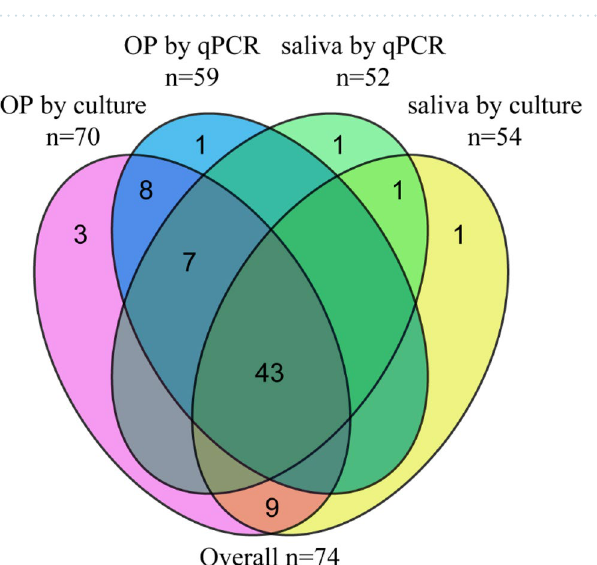
Figure 2. qPCR based detection of Neisseria meningitidis versus isolation of live meningococci from oropharyngeal and saliva samples. A scatter plot of the metA and ctrA qPCR cycle threshold (C T ) values from ( A ) oropharyngeal and ( B ) saliva samples. Each symbol represents an individual sample. Samples with a C T > 25 for both metA and ctrA are considered as positive for meningococcal carriage when tested with molecular methods. In both oropharyngeal and saliva samples, we noted a significant correlation between metA and ctrA for meningococcus positive samples (Spearman’s test p < 0.0001). Red dots represent samples from which meningococcal strain has been cultured. Blue dots represent samples classified as positive for meningococcus when tested with molecular method but negative by culture. Numbers in brackets depict the number (in black) of all samples and (in red) number of samples from which N. menigitidis has been cultured.